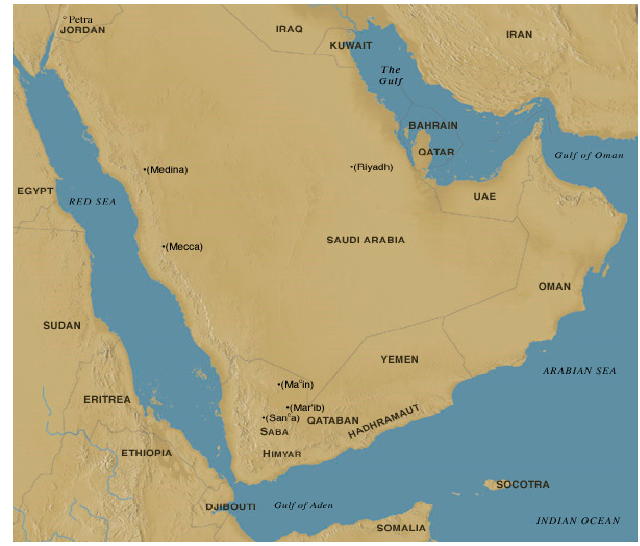
Figure 1. A map representing the study domain of the Arabian Peninsula.